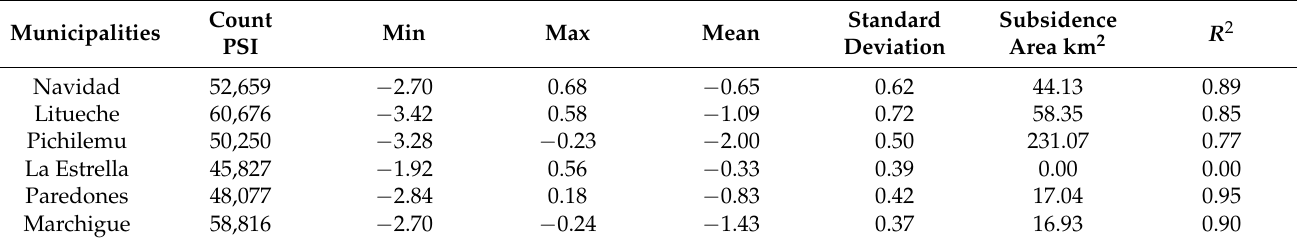
Table 2. Basic statistics of PSI MT-InSAR for